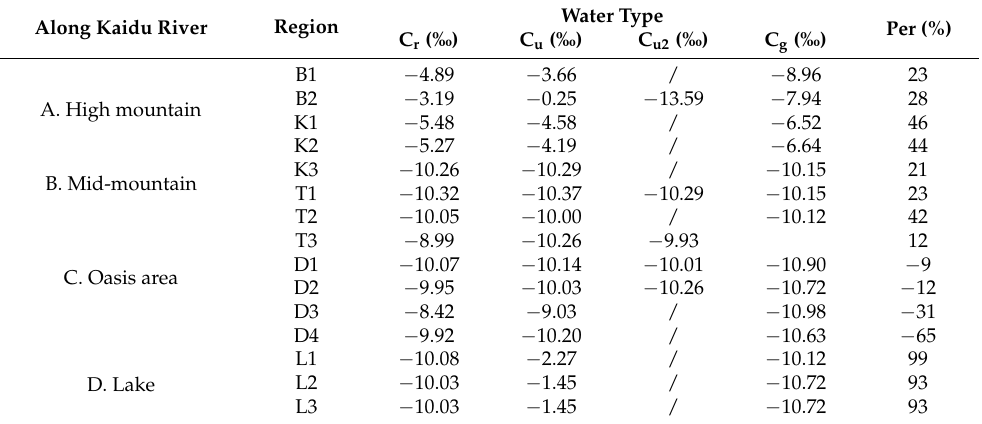
Table 2. The mean concentrations of tracers in different water types and the fractions of groundwater discharged to the